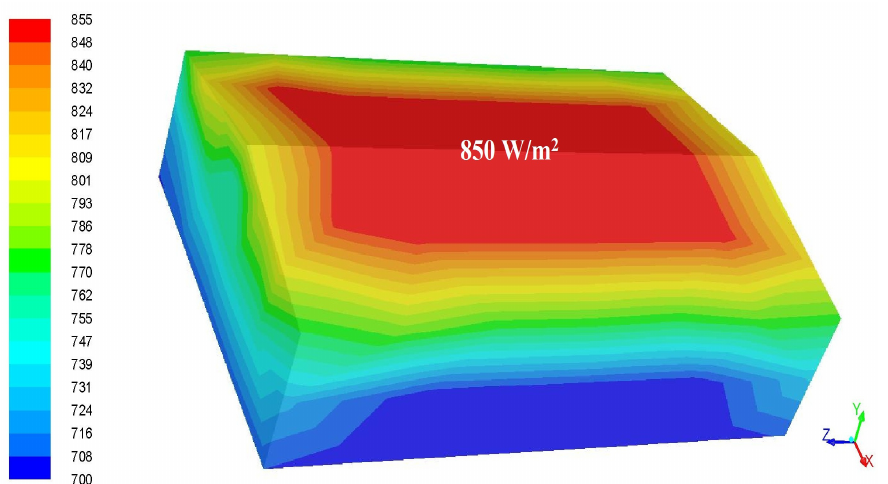
Figure 7. Simulated solar flux received on the side walls and roof of the greenhouse at solar noon.